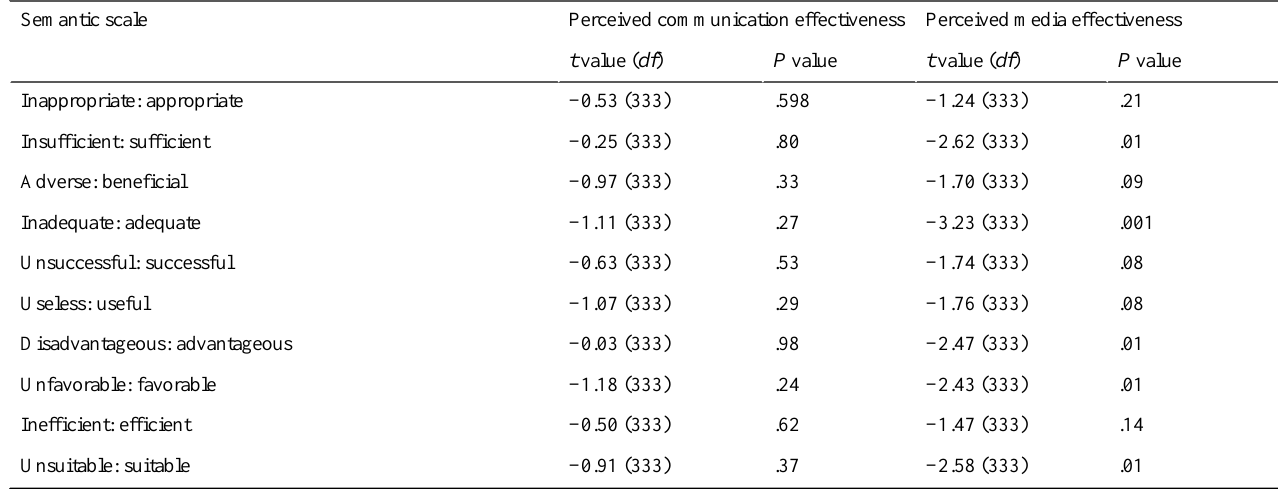
Table 4. Group comparison for perceived communication effectiveness and perceived media